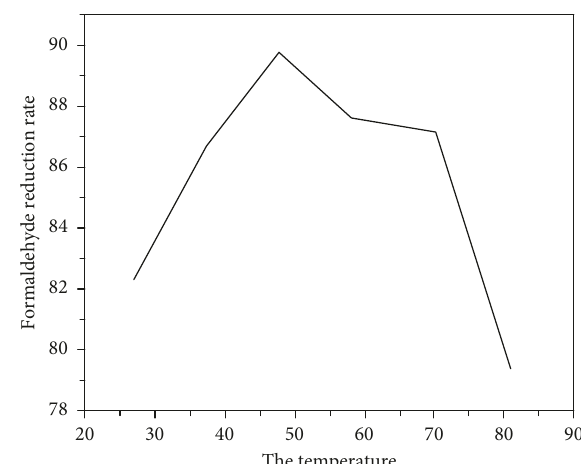
Figure 5: Influence of humidity on the formaldehyde degradation rate of photocatalytic coatings.